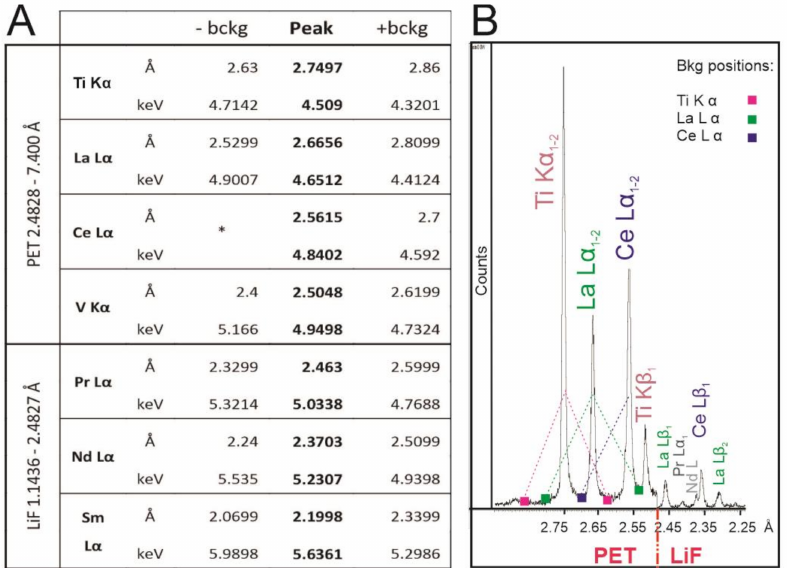
Figure 3. ( A ) Background positions for the X-ray L lines of elements analysed. Note * One bckg selected only because of the limitation of the crystal range. ( B ) Visual representation of X-ray peaks for the closely spaced major elements (Ti, La, Ce) analysed here and the selection of their background positions. Note a step-in background at 2.475 Å related to the change of diffracting crystals from PET to LiF during data